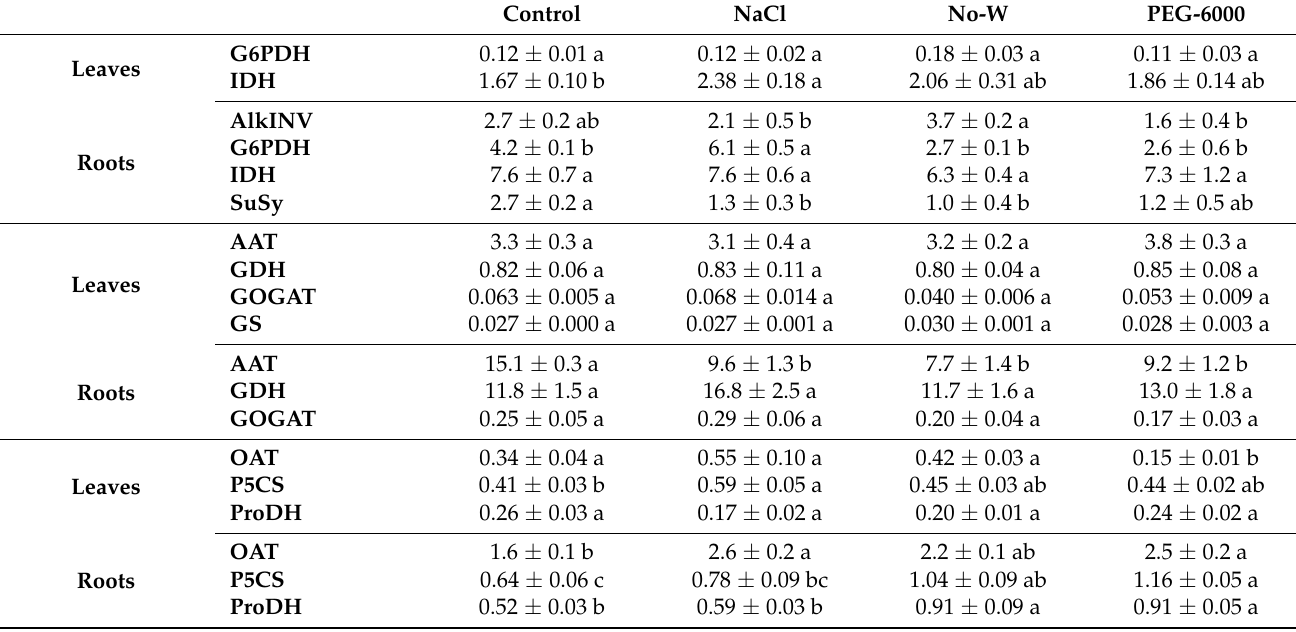
Table 5. Effect of the different water-stress treatments on several enzymatic